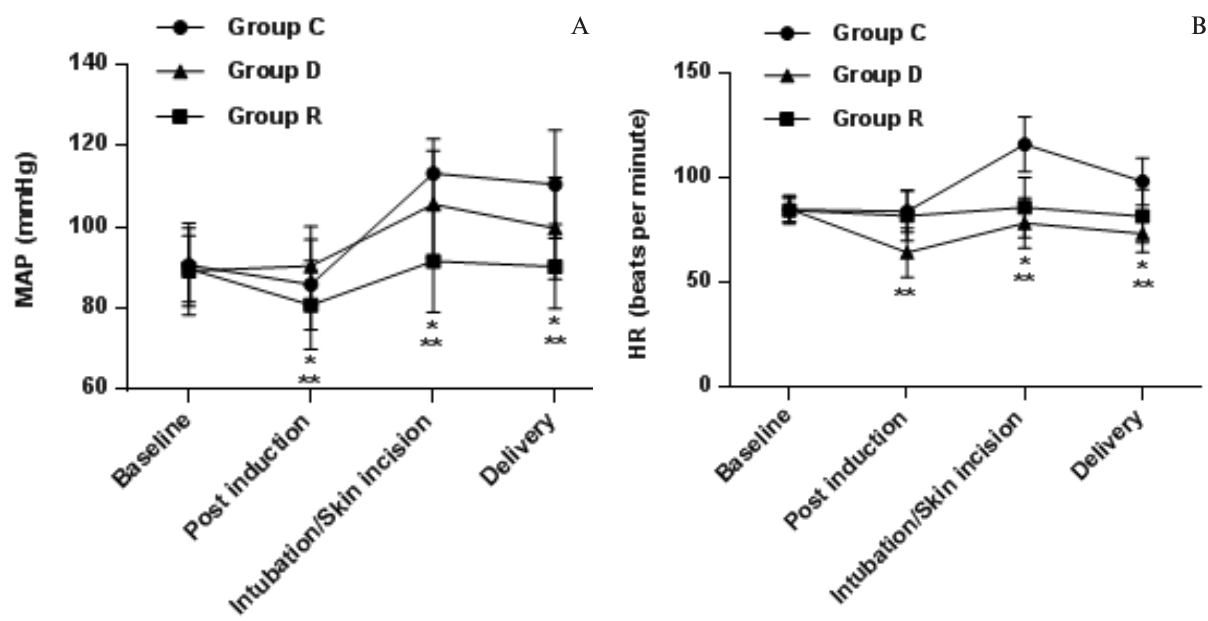
Fig. 2. The MAP and HR in the three groups. Compared with the control group, MAP were significantly lower in dexmedetomidine group at post induction, intubation/skin inci- sion and delivery, * P <0.05; compared with the control and dexmedetomidine group, MAP were significantly lower in remifentanil group at post induction, intubation/skin incision and delivery, ** P <0.05 (A). Compared with the control group, HR were significantly lower in remifentanil group at intubation/ skin incision and delivery, * P <0.05; Compared with the control and remifentanil group, HR were significantly lower in dexmedetomidine group at post induction, intubation/skin incision and delivery, ** P <0.05 (B).Values are presented as the mean ± standard deviation.